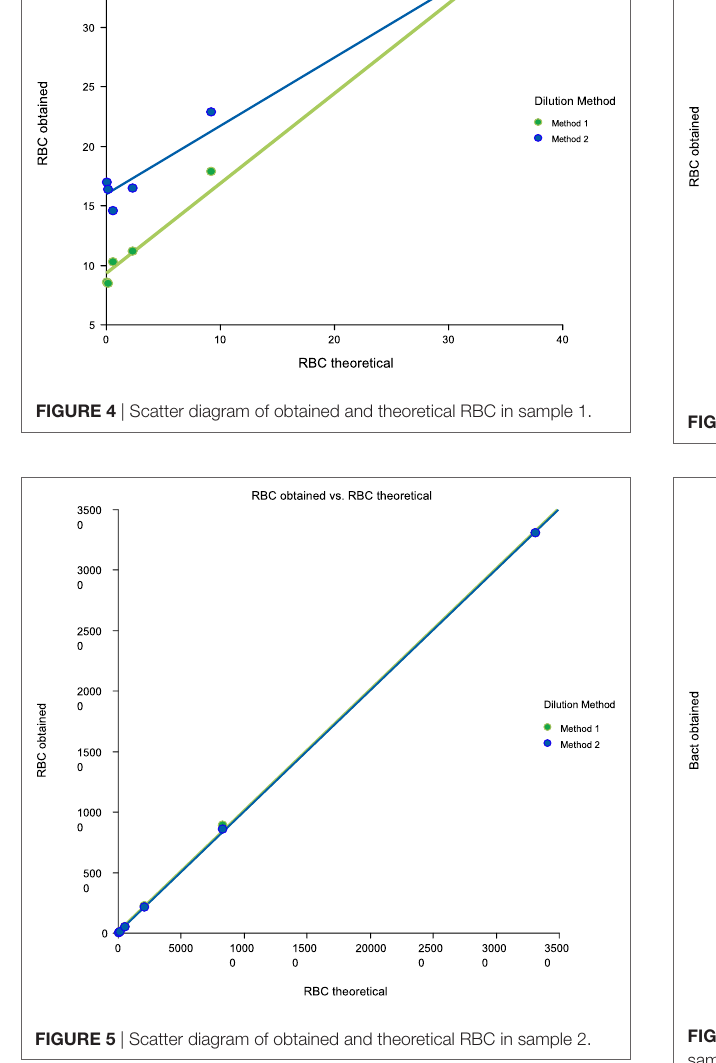
and 99.4%, respectively. The most balanced cut-off value was 3.8